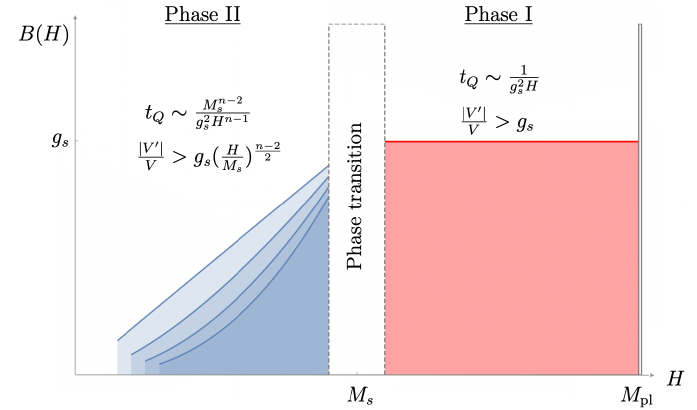
Figure 8 . Schematic behavior of lower bound B ( H ) in the perturbative case with M s (cid:28) M pl for dimensions n = 4 , 5 , 6 , 7 . Shading corresponds to quantum breaking excluded region for | V 0 | /V